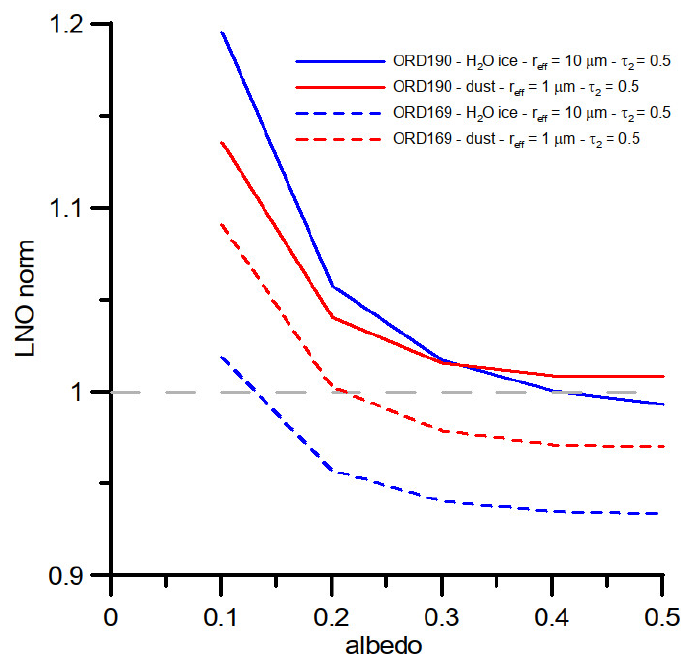
Figure 2. Simulated LNO Norm vs. arbitrary albedo obtained by the MITRA tool. The simulations have been performed for water ice and dust using orders 190 and 169. See the legend on the panel for the colour definition.